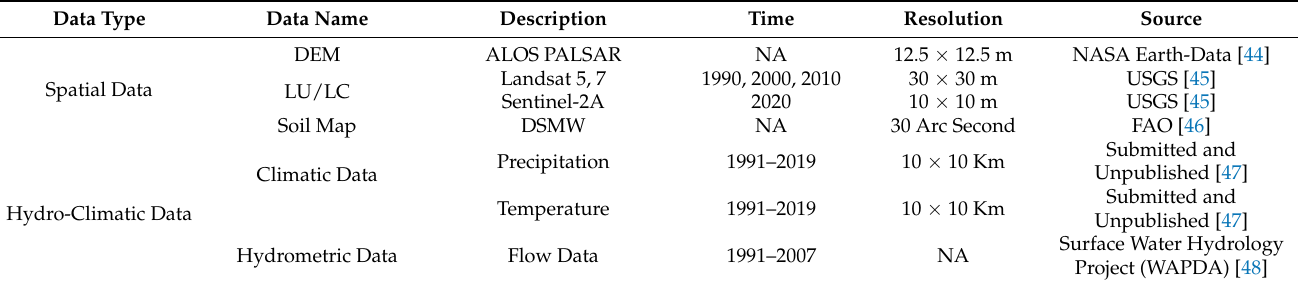
Table 1. Details of geo-hydro-climatic input datasets.